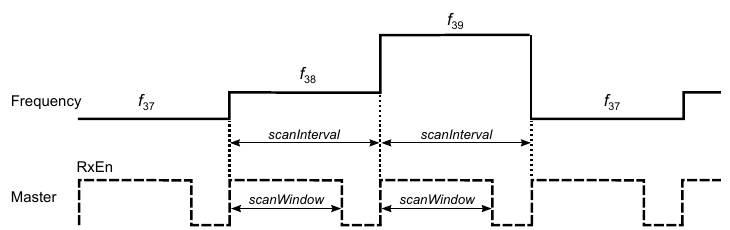
Figure 4. Scan window and scan interval—in the Initiating State, master listens (RxEn is set high) on the 3 primary advertising channels for the advertising packets. On each channel, RxEn is set high for the duration of scanWindow , while the interval between the start of two consecutive scan windows equals scanInterval . If scanWindow = scanInterval , the master listens continuously. Inter frame space —the time interval T _ IFS = 150 us between two consecutive packets on the same channel index ([24] p. 2927);